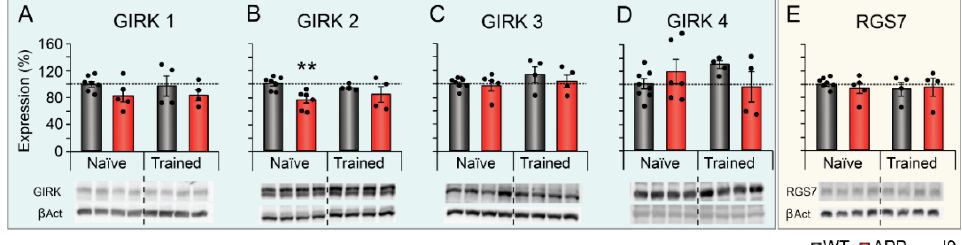
Figure 4. Effect of genotype and spatial memory training on hippocampal levels of GIRK channel subunits and modulator. Protein levels of GIRK channel subunits (1–4) and modulator (RGS7) in the hippocampus of naïve and memory-trained non transgenic (WT) and APP Sw,Ind J9 mice at 6 months of age. ( A ) GIRK1, ( B ) GIRK2, ( C ) GIRK3, ( D ) GIRK4 and ( E ) RGS7. Data is expressed as percentage relative to untrained naïve WT mice (100%). ** p < 0.01 vs. naïve WT. β Act, β actin. However, whereas GIRK 2 levels were decreased in naïve APP Sw,Ind J9 mice compared to naïve WT mice, these changes were not detected after memory training (Figure 4B).